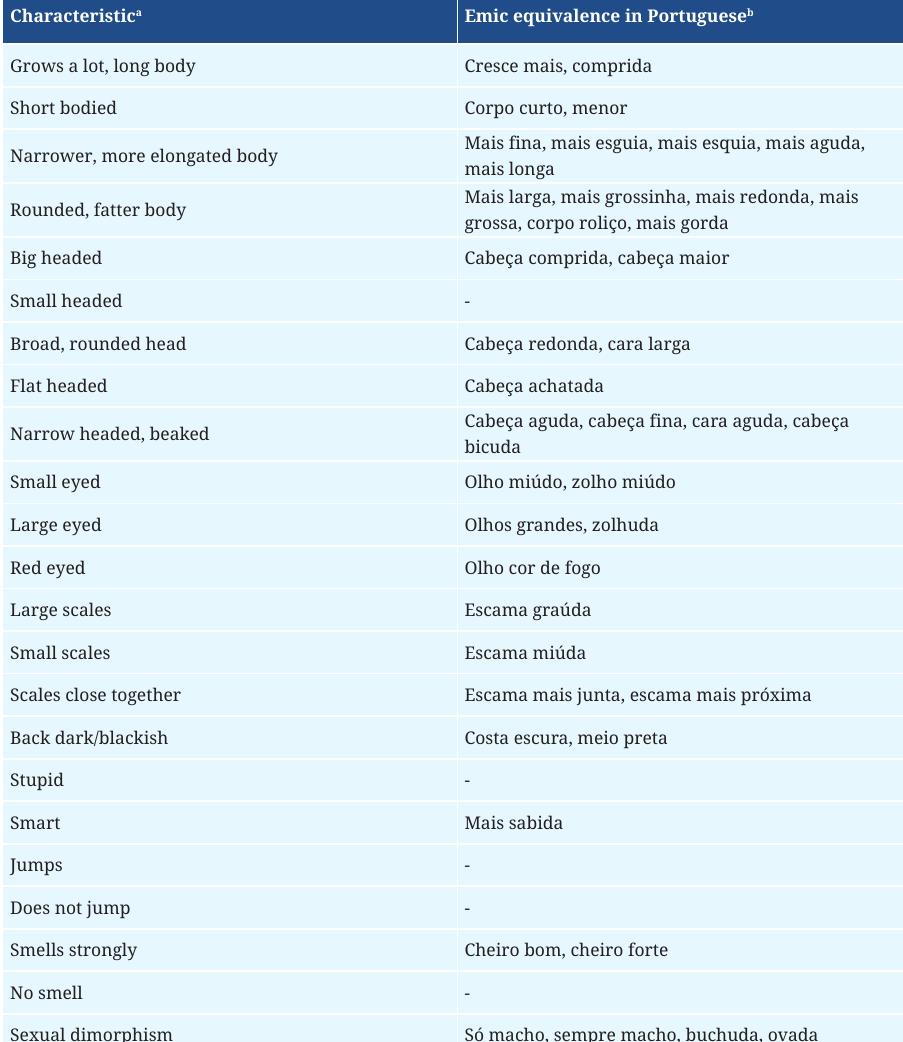
TABLE 1 | Characteristics and equivalences used by fishers to describe the fish of the family Mugilidae in the Caeté-Taperaçu Marine Extractive Reserve in Bragança, northern Brazil. a: Technical characteristics, b: Equivalent characteristics according to the fishers